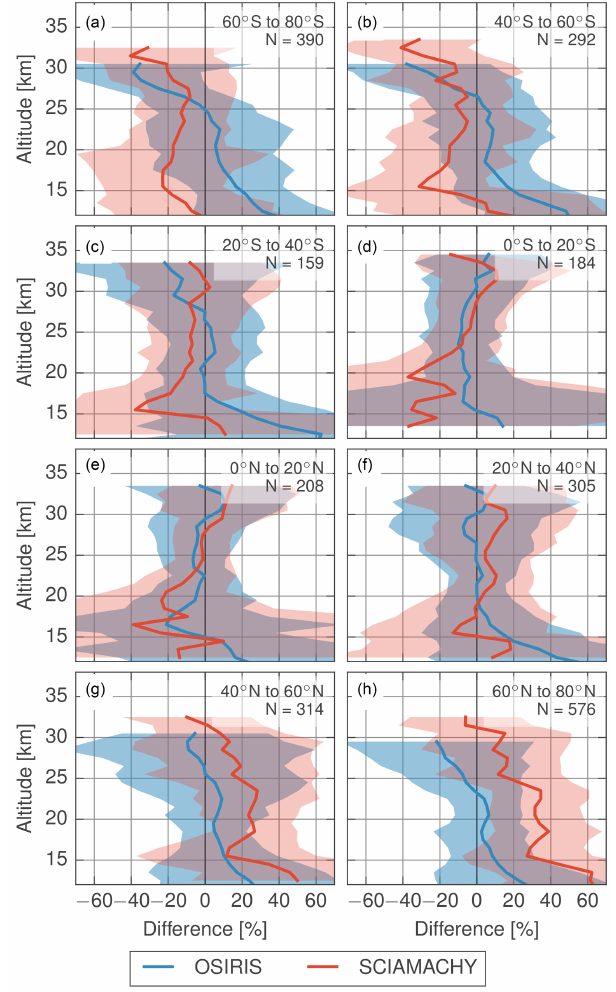
Figure 1. Coincident comparison between OSIRIS and SCIA- MACHY measurements compared to SAGE II. Difference com- puted as (Instrument − SAGE II)/SAGE II × 100%. Shaded regions indicated one SD of the differences from the